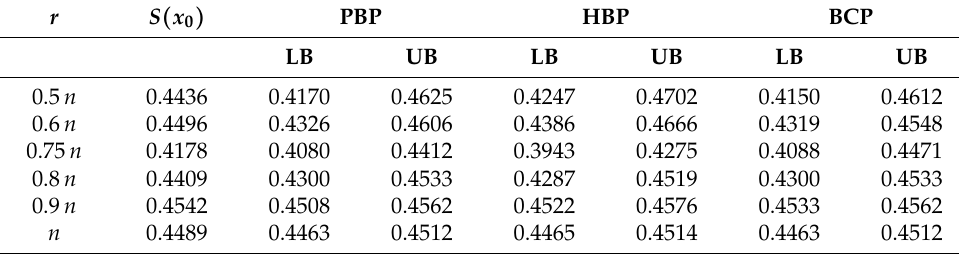
Figure 5. The MLEs of Mixture PDFs of Example 1. Table 7. 95% Confidence intervals of the survival function at x 0 =